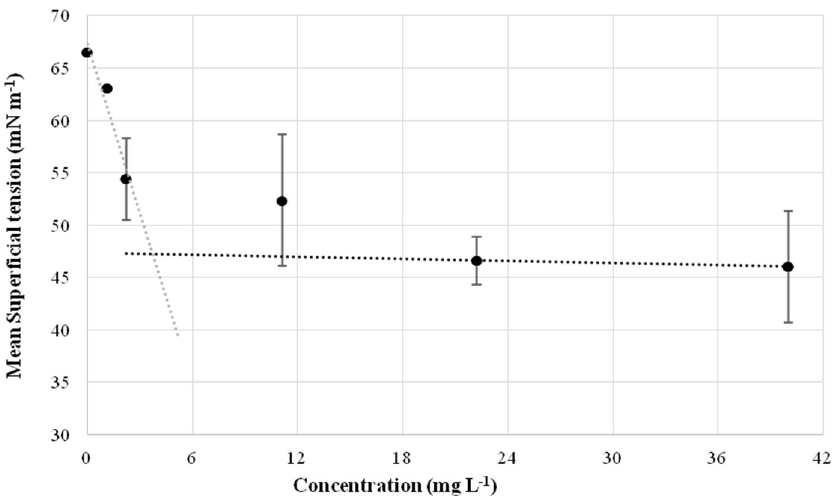
Figure 8. Analysis of surface tension and calculation of critical micelle dilution (CMD) of the purified biosurfactant compound extracted from R . opacus R7 CFS after 48 h of growth on naphthalene. The black dots represent the measured surface tension of the purified biosurfactant at different concentrations (dilutions in water). The grey dotted line represents the biosurfactant monomers while the black dotted line represents the biosurfactant micelles. Their intersection represents CMD, the estimated CMC is around 20 mg L −1 .